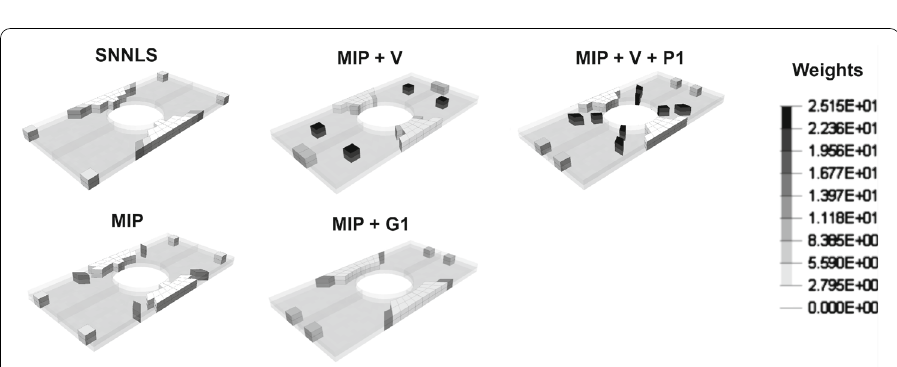
Fig. 6 Element selection for the hyper-reduced integration schemes of size seven computed with the different methods